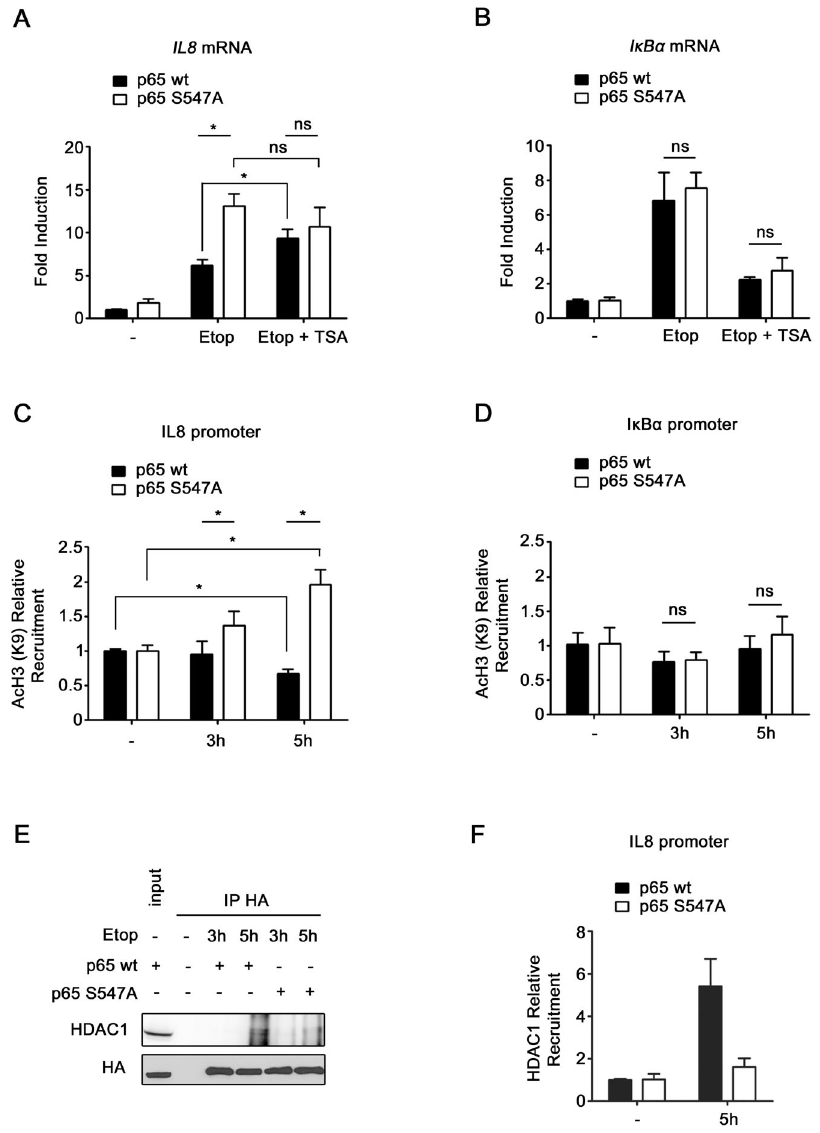
Figure 8. Ser 547 phosphorylation–dependent IL8 gene regulation mechanism involve HDAC. ( A–B ) HEK-293 expressing either p65 wt or p65 S547A were non-treated or treated 4 hours with etoposide in absence or presence of TSA, and mRNA levels of IL8 ( A ) and I k B a ( B ) were analyzed by qRT PCR. ( C–D ) Recruitments of Lys 9 acetylated histone 3 on IL8 ( C ) and I k B a ( D ) promoters were measured by ChIP assay in HEK-293 cells expressing either p65 wt or p65 S547A , and treated with etoposide for the indicated periods. ( E ) HA-tagged p65 wt or p65 S547A were immunoprecipitated from lysates of HEK-293 cell transfected with expression plasmid for these two proteins or non transfected as control. Co-immunoprecipitated HDAC1 protein was detected by western blotting (upper panel). Level of immunoprecipitated HA-p65 in the different samples was determined by western blotting (lower panel). A portion of whole cell extract was added on the gel as input. ( F ) Recruitment of HDAC1 on IL8 promoter was measured by ChIP assay in HEK-293 cells expressing either p65 wt or p65 S547A , and treated 5 hours with etoposide or left untreated. *, significantly different (P , 0.05); ns, non significantly